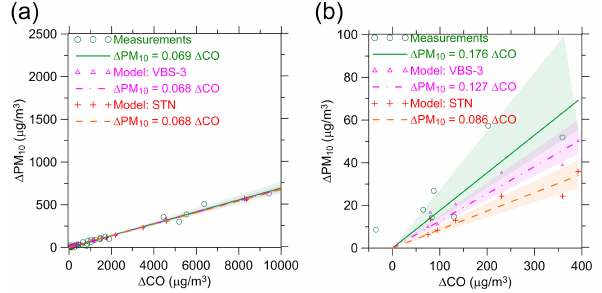
Figure 7. Scatterplots of the enhancements of PM 10 and CO con- centrations ( (cid:49) PM 10 and (cid:49) CO) in (a) Moscow and (b) Kuopio on days affected by smoke from fires. Note that the relative scales of the (cid:49) PM 10 and (cid:49) CO values are the same in both plots. The slope of a linear fit (through the origin) to the data provides an estimate of NEMR (see Sect. 3.1). The shaded areas depict uncertainties of the fits at the 95% confidence